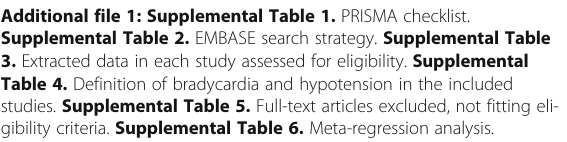
Additional file 1: Supplemental Table 1. PRISMA checklist. Supplemental Table 2. EMBASE search strategy. Supplemental Table 3. Extracted data in each study assessed for eligibility. Supplemental Table 4. Definition of bradycardia and hypotension in the included studies. Supplemental Table 5. Full-text articles excluded, not fitting eli- gibility criteria. Supplemental Table 6. Meta-regression